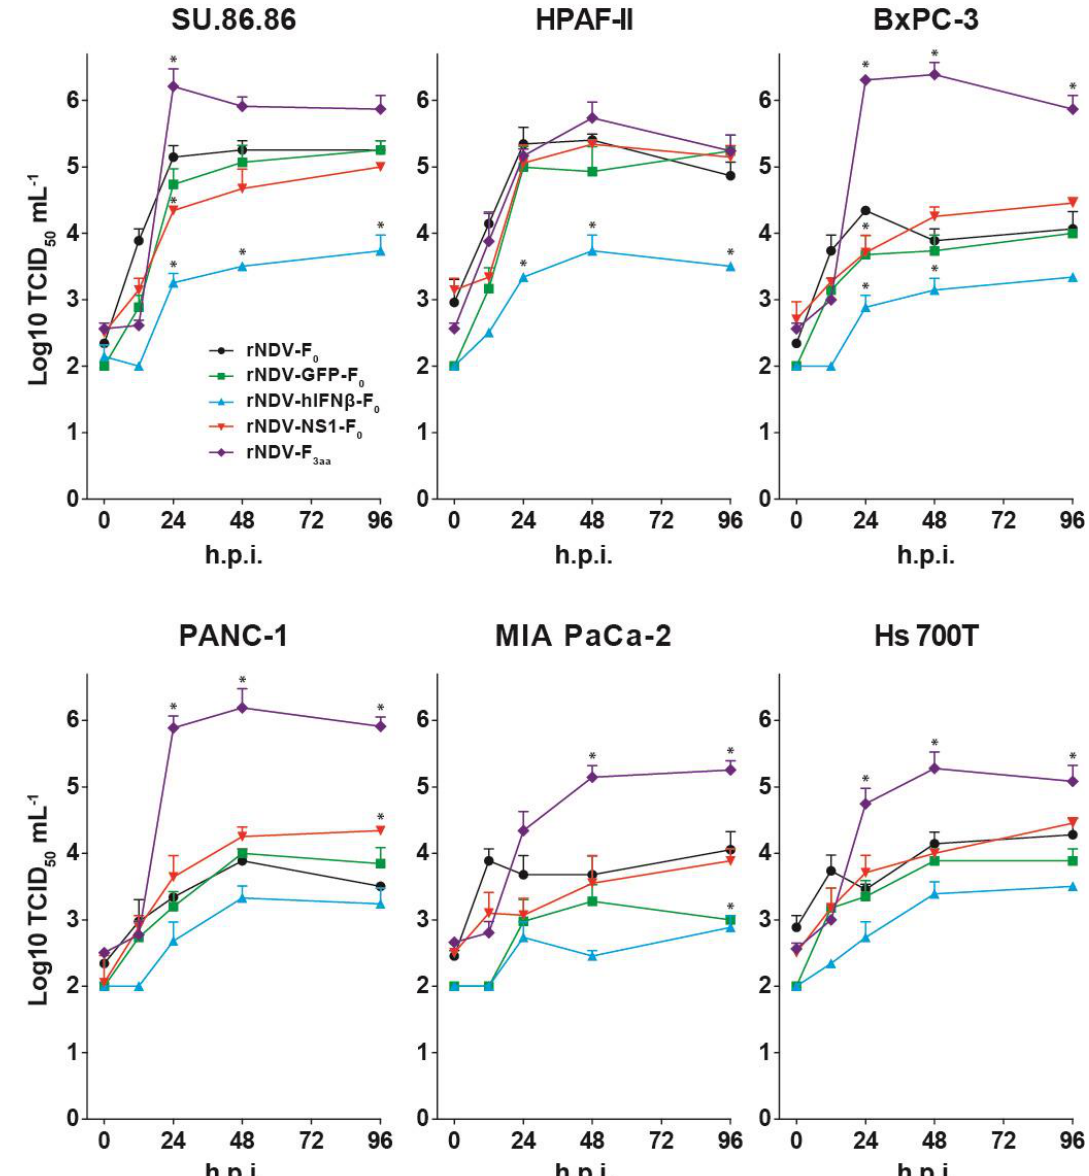
Figure 2. Replication kinetics of rNDVs in 6 different human pancreatic adenocarcinoma cell lines (HPACs). Cells were inoculated in triplo with m.o.i. 0.1 and samples were taken at indicated time points and titrated by end-point dilution assay in Vero-118 cells. Means and standard deviations of duplicate titrations are plotted. H.p.i.: hours post inoculation. * = p < 0.05 vs . rNDV-F 0 (one-way ANOVA + Bonferroni post-test), tested for time points 24, 48 and 96 h.p.i.